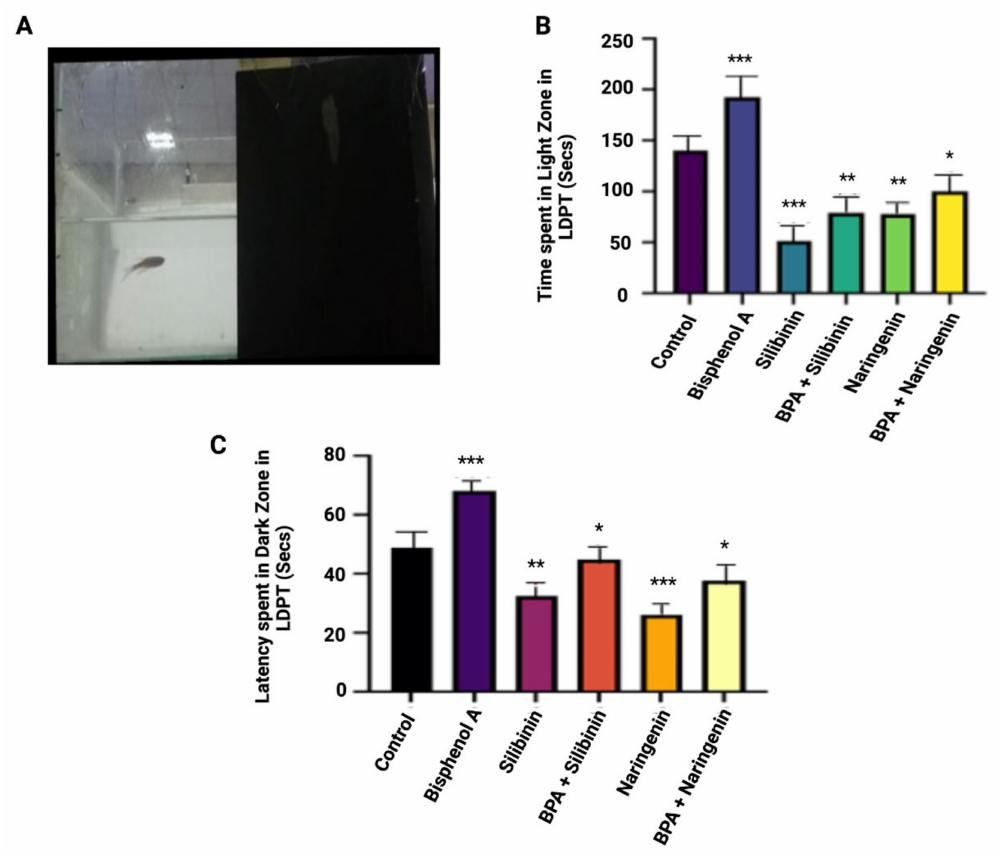
Figure 5. ( A ) Light and dark preference tank test and ( B ) times spent in the light cone in LDPT (Seconds) ( C ) The latency spent in the dark zone in LDPT (seconds). The values are expressed as means ± SEM, n = 10 fish in each groups. Significance was determined using a one-way ANOVA. Note: * p < 0.05, ** p < 0.01, *** p < 0.001 compared with the control